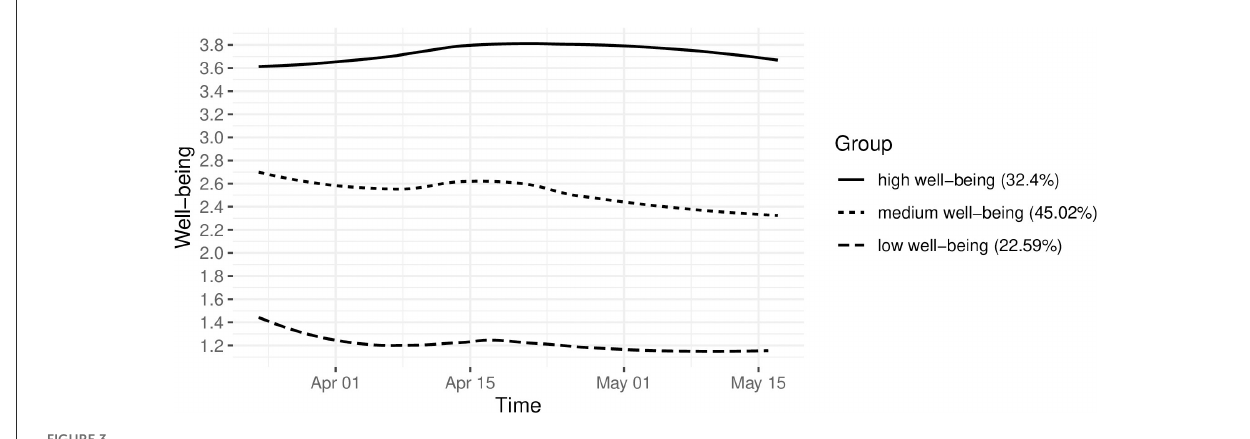
FIGURE3 Group trajectories of observed average well-being